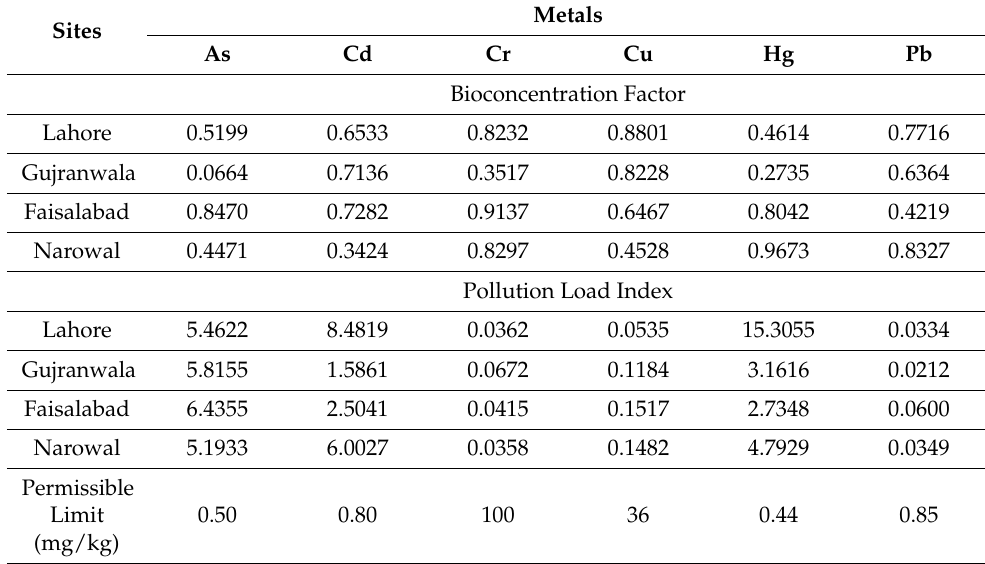
Table 2. Bioconcentration factor and pollution load index of rice in selected areas.